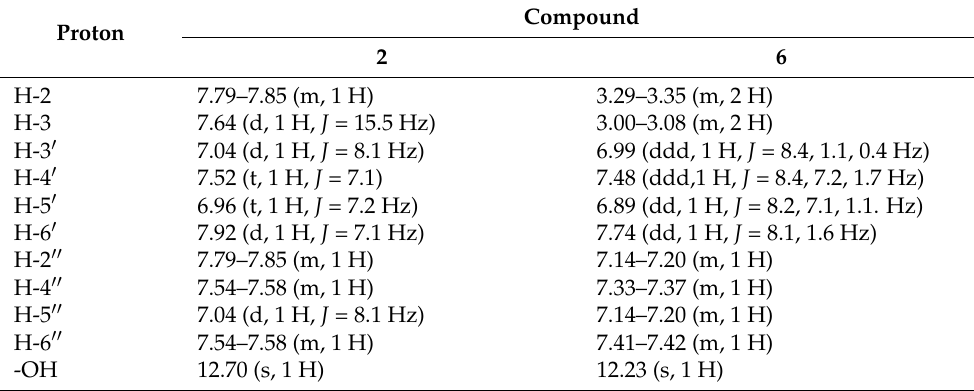
Table 5. Summary of signals visible in the 1 H NMR spectrum of the substrate ( 2 ) and the biotransfor- mation product ( 6 ).